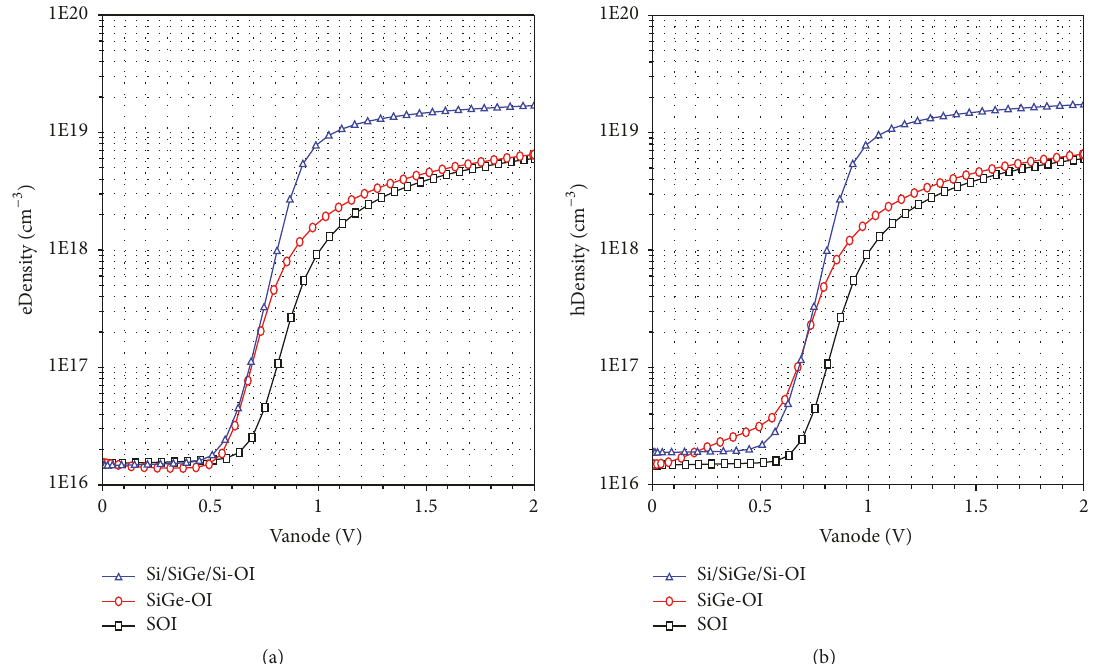
Figure 6: The relationship between the carriers concentration and modulation voltage: (a) electron concentration and (b) hole concentration for three